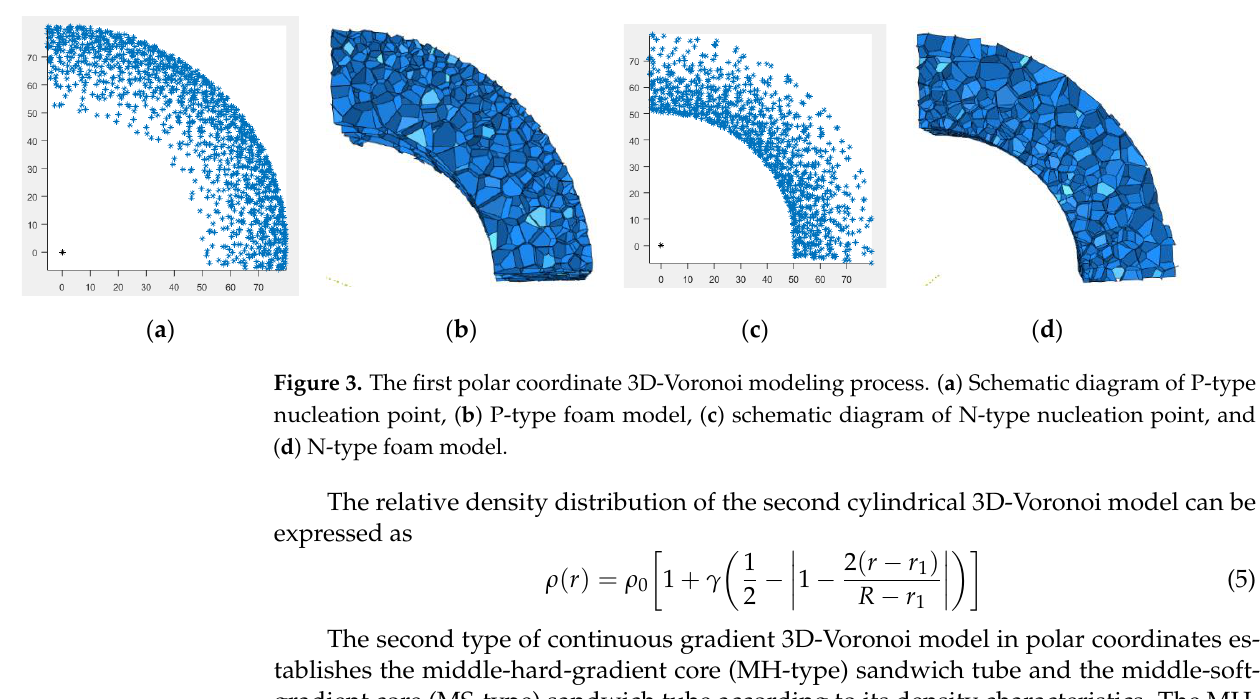
( d ) Figure 3. The first polar coordinate 3D-Voronoi modeling process. ( a ) Schematic diagram of P-type nucleation point, ( b ) P-type foam model, ( c ) schematic diagram of N-type nucleation point, and ( d ) N-type foam model.